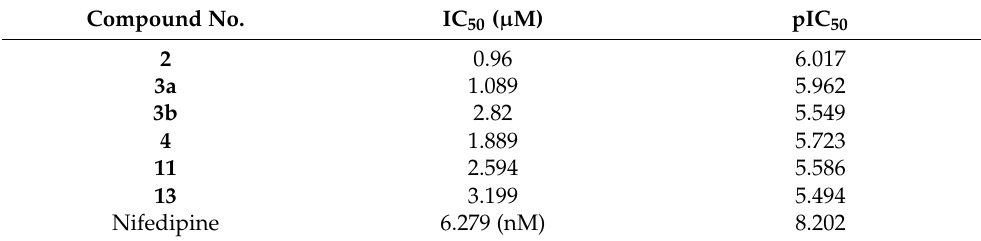
Table 3. Quantitative assessment of active compounds expressed as IC 50 and PIC 50 on isolated rabbit jejunum. ( n = 3–4) a